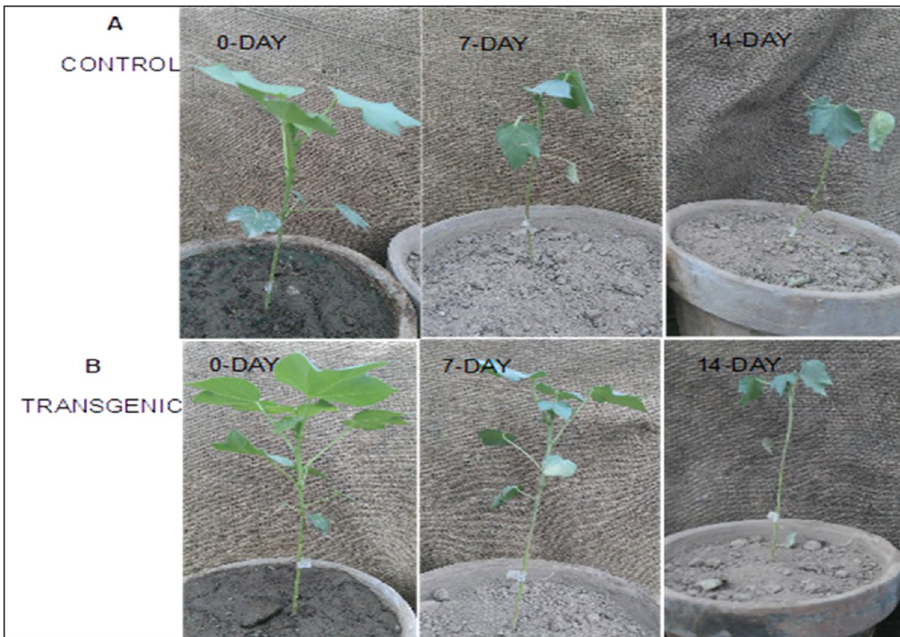
Figure 5. Comparison of drought stress at 0-Day, 7-Day and 14-Day ( A ) Control non-transgenic ( B ) Agl42_ transgenic